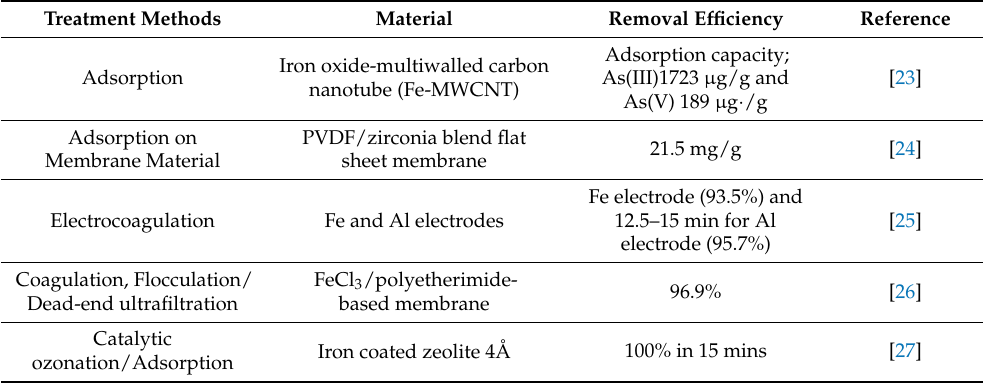
Table 1. Arsenic removal in drinking water through various